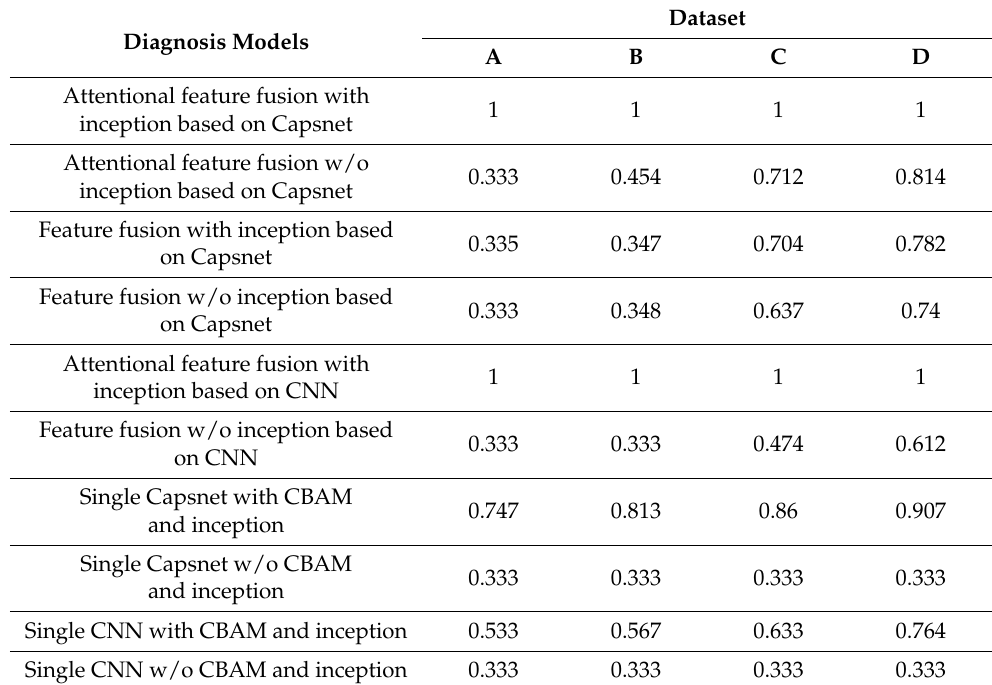
Table 4. Diagnosis accuracy of different methods using different training